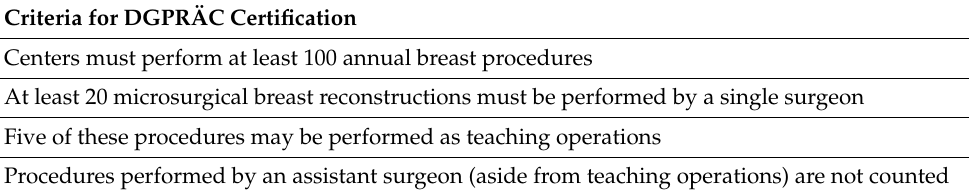
Table 1. Criteria defined by the German Society of Plastic, Reconstructive and Aesthetic Surgeons (DGPRÄC) for the certification of plastic-surgical centers that entered data into the national online registry for microsurgical breast